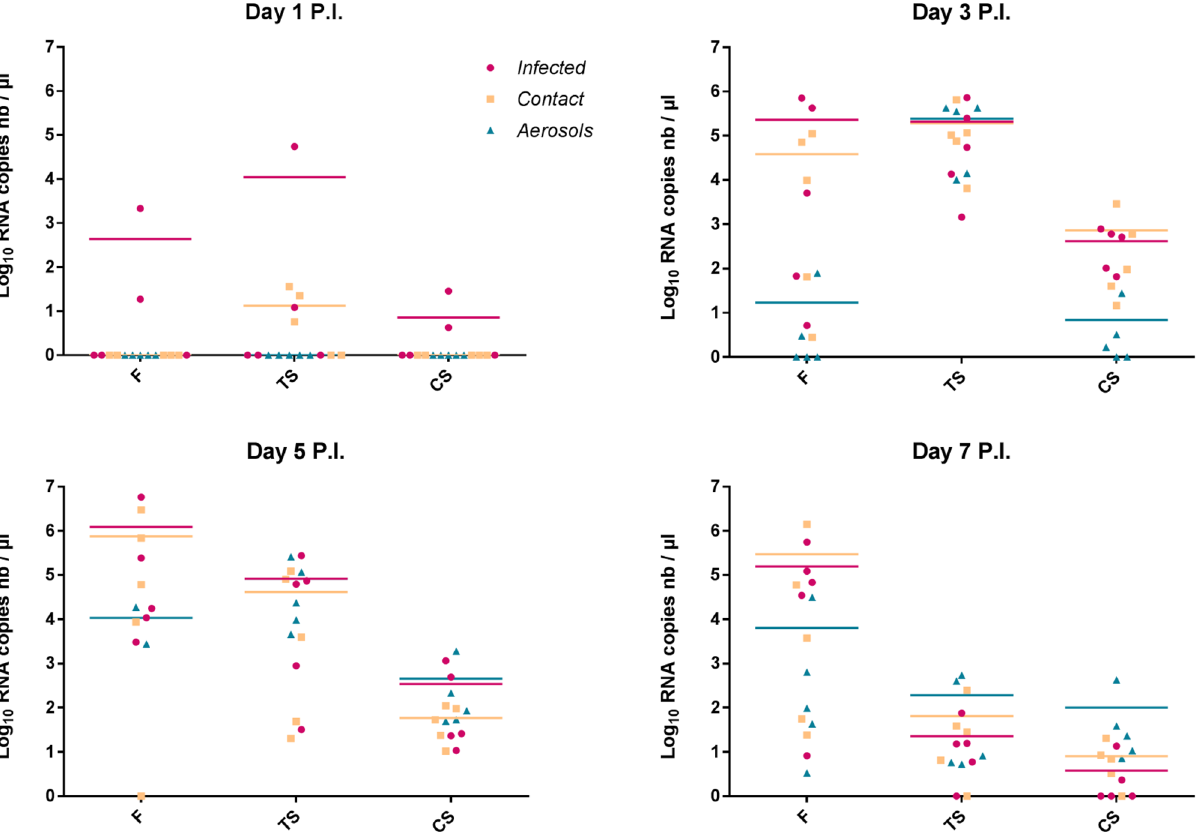
Figure 4. Viral RNA loads in experimentally H5N8-infected 10-week-old mule ducks.Virus loads in feathers (F), tracheal swabs (TS) or cloacal swabs (CS) were determined from day 1 to day 7 post-infection for infected (pink), contact (yellow) and aerosol (blue) groups. Absolute quantification was performed by RT-qPCR targeting the viral M gene from extracted RNAs in parallel with an M gene plasmid range. Each dot represents an individual value and horizontal bars correspond to means. limit of detection for each